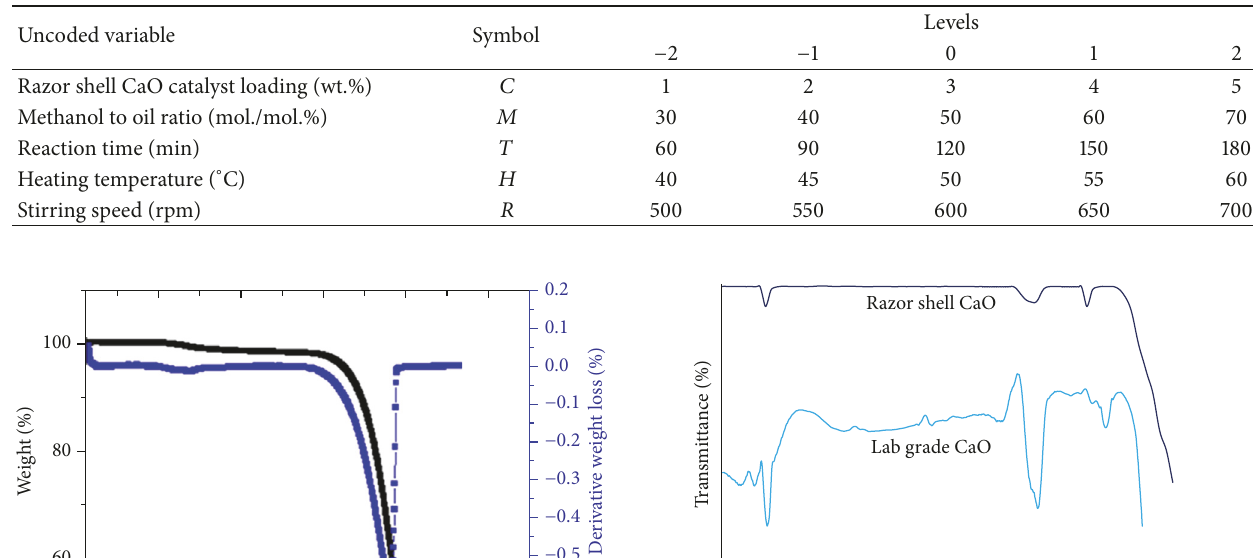
Table 1: Factors and their uncoded levels.